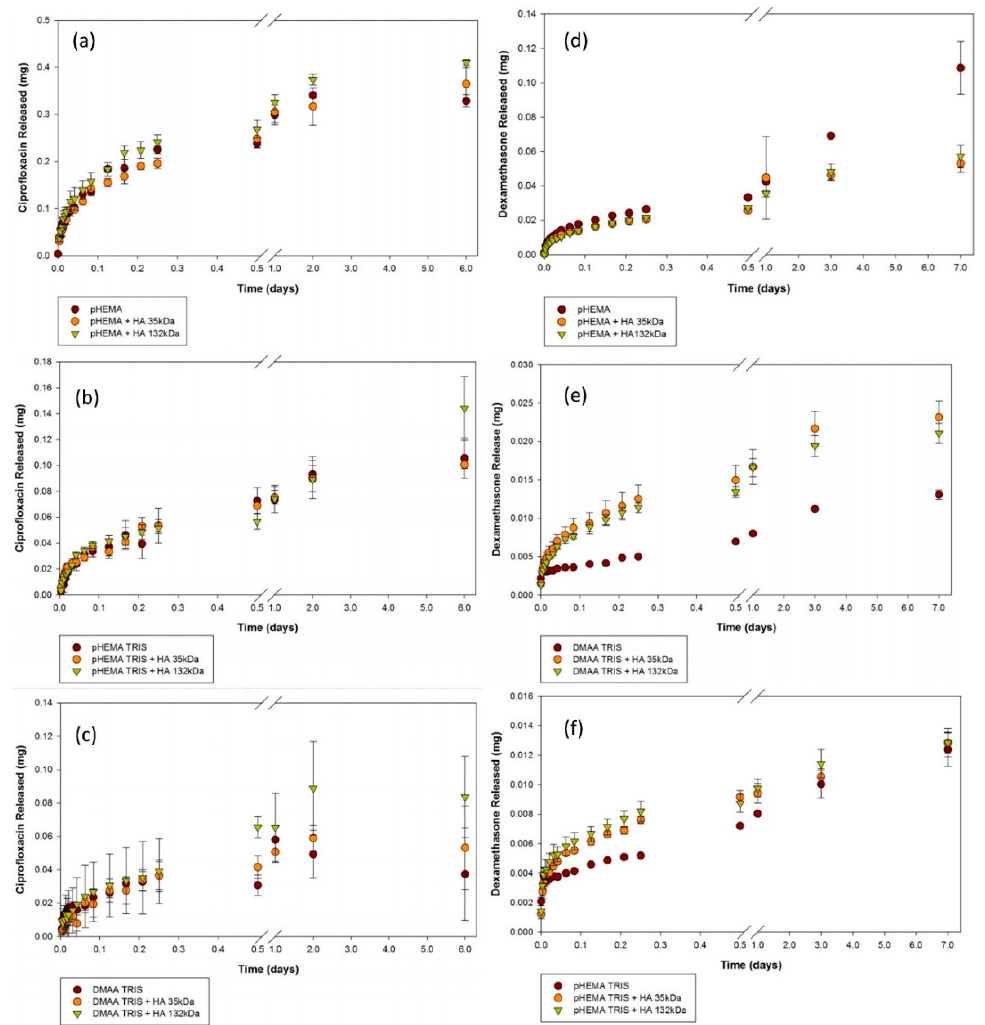
Figure 12. Ciprofloxacin release curves from ( a ) pHEMA, ( b ) pHEMA TRIS and ( c ) DMAA TRIS materials. Values plotted are means ± SD. HA 35 kDa = 35 kDa hyaluronic Acid. HA 132 kDa = hyaluronic Acid 132 kDa. Dexamethasone phosphate release curves from ( d ) pHEMA, ( e ) pHEMA TRIS and ( f ) DMAA TRIS materials. Values plotted are means ± SD. HA 35 kDa = 35 kDa Hyaluronic Acid. HA 132 kDa = hyaluronic Acid 132 kDa. From [88].